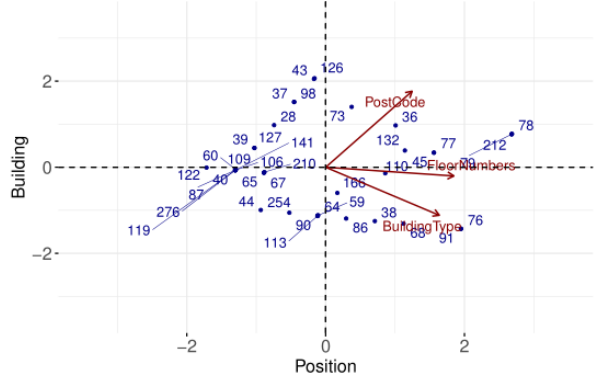
Figure 9. Results of the third PCA analysis: ( a ) the correlation circle and ( b ) percentage contributions of the factors that formed the main components (see Table 1).